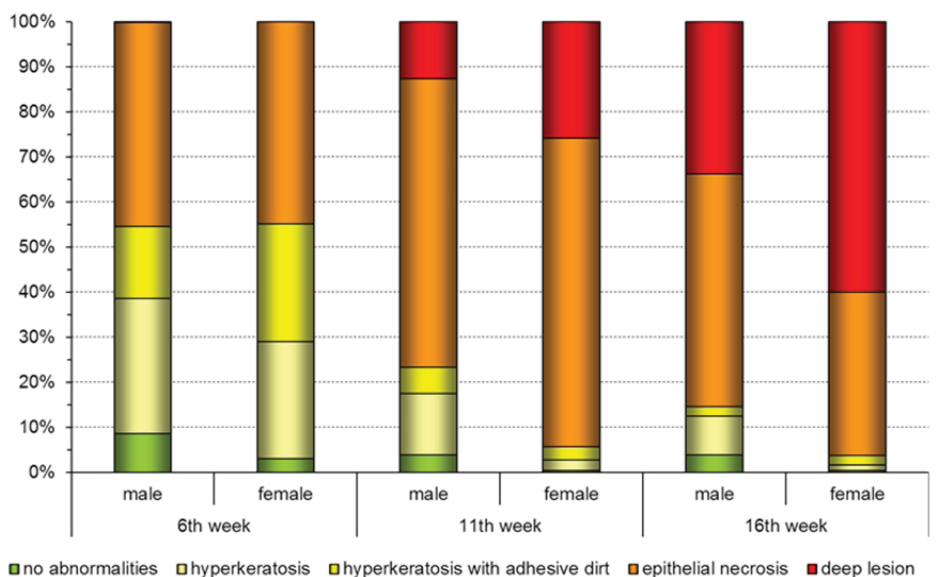
Figure 2. Relative distribution of foot pad alterations per age group in male and female fattening turkeys. Results from the clinical